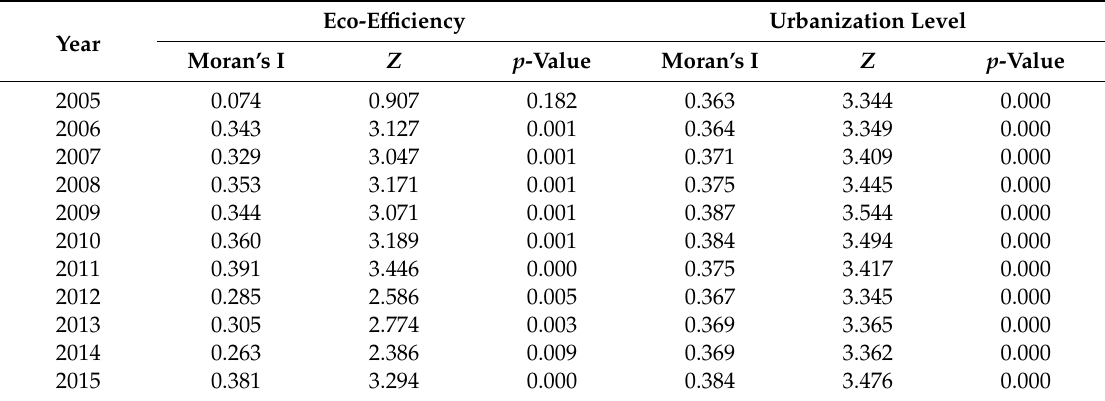
Table 2. Spatial correlation for regional eco-e ffi ciency and urbanization in China from 2005 to